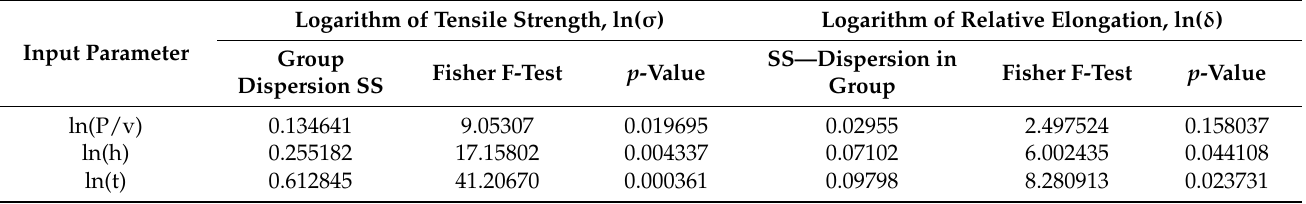
Table 5. ANOVA univariate test of Equations (28) and (29).